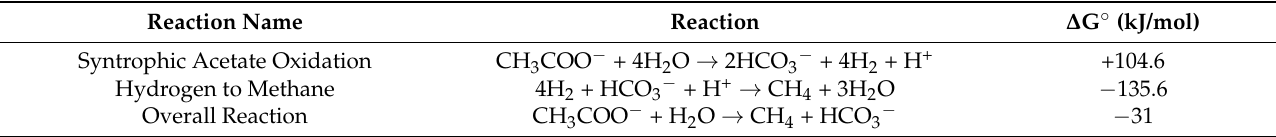
Table 1. Syntrophic acetate oxidation linked to hydrogen conversion to